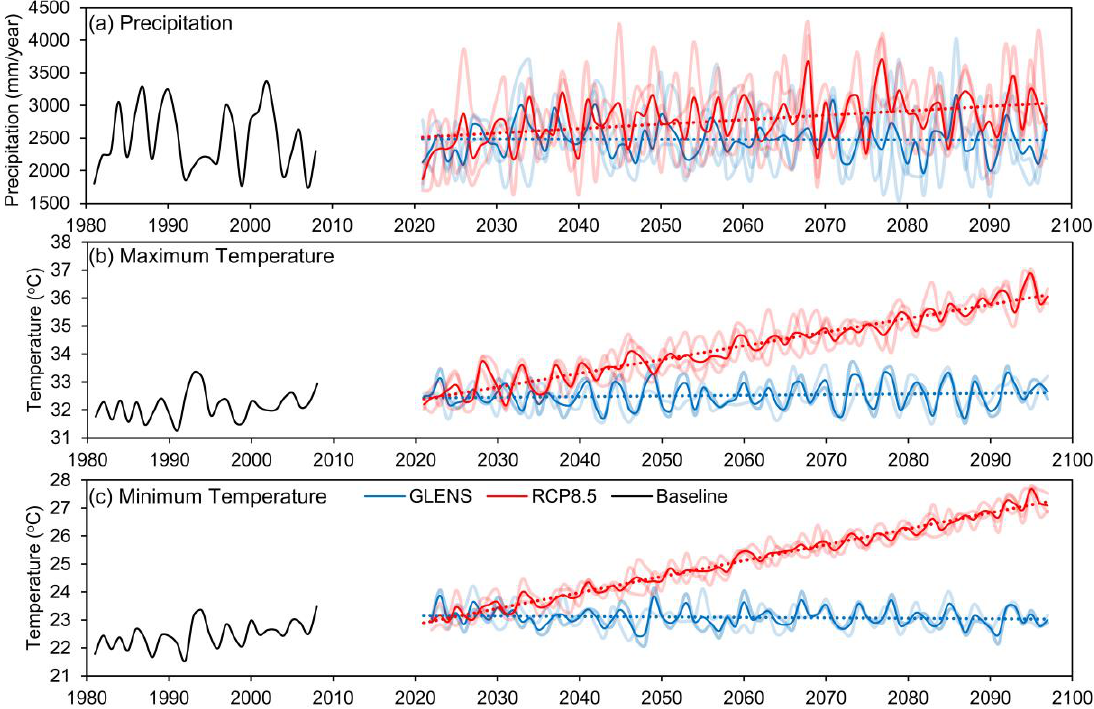
Figure 4. The comparison of catchment averaged daily rainfall and maximum temperature and minimum temperature climatology of the raw GCM simulation and bias-corrected GCM simulation against the observed values from 1981 – 2009.